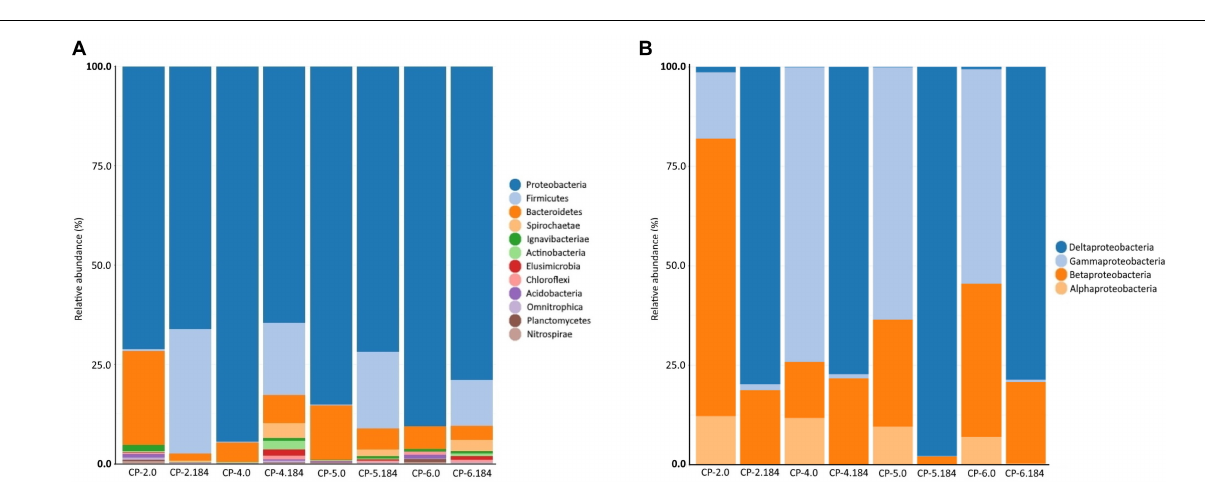
FIGURE 9 | Alpha -diversity of microbial communities in groundwater samples from CP-2, CP-4, CP-5, and CP-6 monitoring wells, before the treatment (Initial) and at 184 days after the addition of nZVI, calculated from Illumina data. (A) Abundance-based Coverage Estimator; (B) Faith’s Phylogenetic Diversity; (C) Shannon-Wiener index; (D) ENS PIE metrics; (E) Evenness (Pielou’s J ).